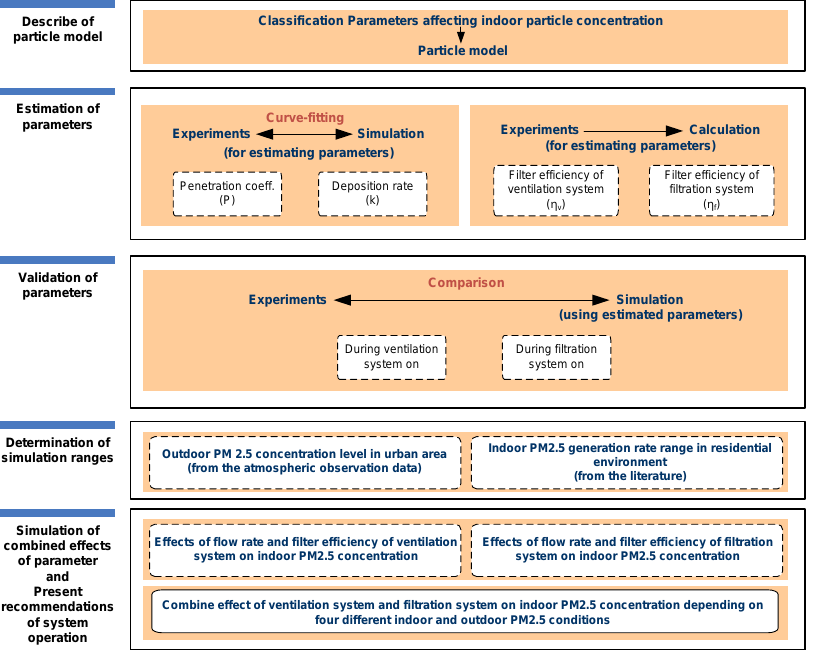
Figure 1. Research process and method.